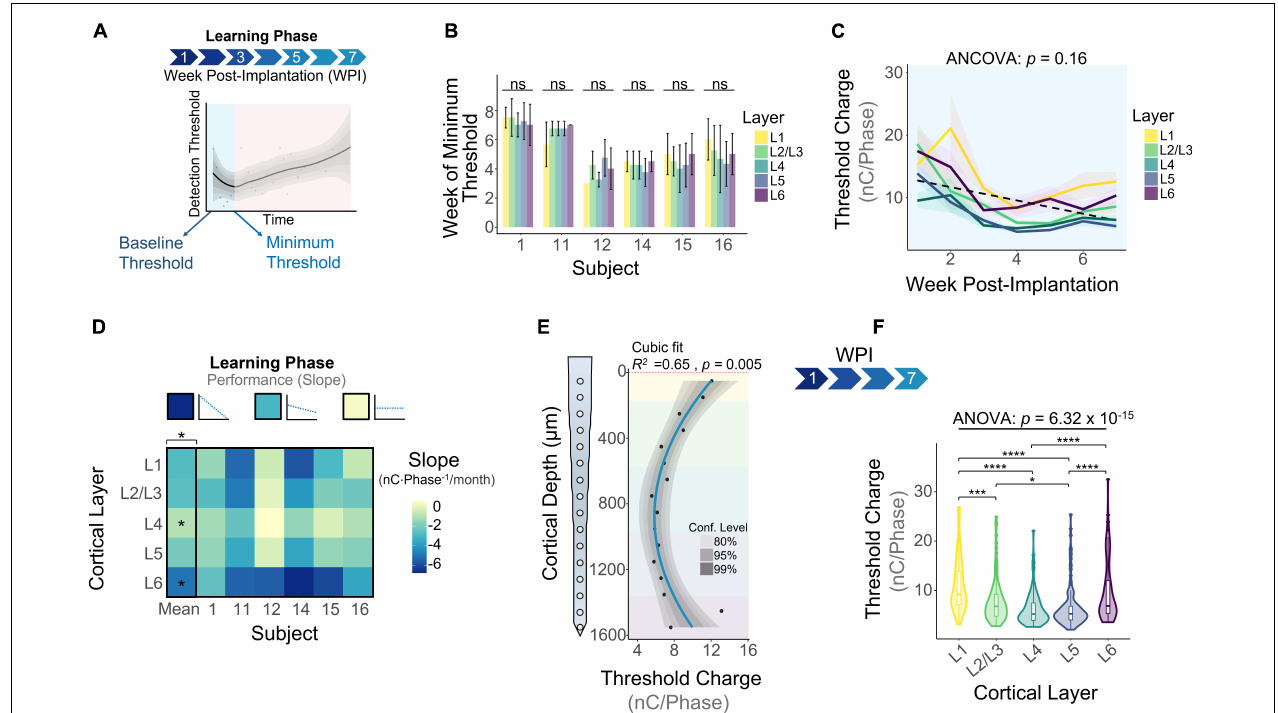
FIGURE 4 | Microstimulation detection thresholds during the learning phase. (A) Graphical representation of the period of initial decrease in thresholds (learning phase) in the context of longitudinal thresholds. (B) Bar plot graph showing the week in which subjects reached minimum thresholds across cortical layers. (C) Average detection thresholds during the learning phase. Dashed line represents a linear regression of the mean. (D) Heatmap of the slope of thresholds between the baseline and week of minimum threshold across subjects. (E) Sensitivity of thresholds during the learning phase and (F) laminar quantification. Analysis of variance and pairwise comparisons between layers were performed with a one-way ANOVA with Tukey’s post-hoc test. Error bars in (B) and shaded areas in (C) indicate mean ± SEM. * p ≤ 0.05, *** p ≤ 0.001, **** p ≤